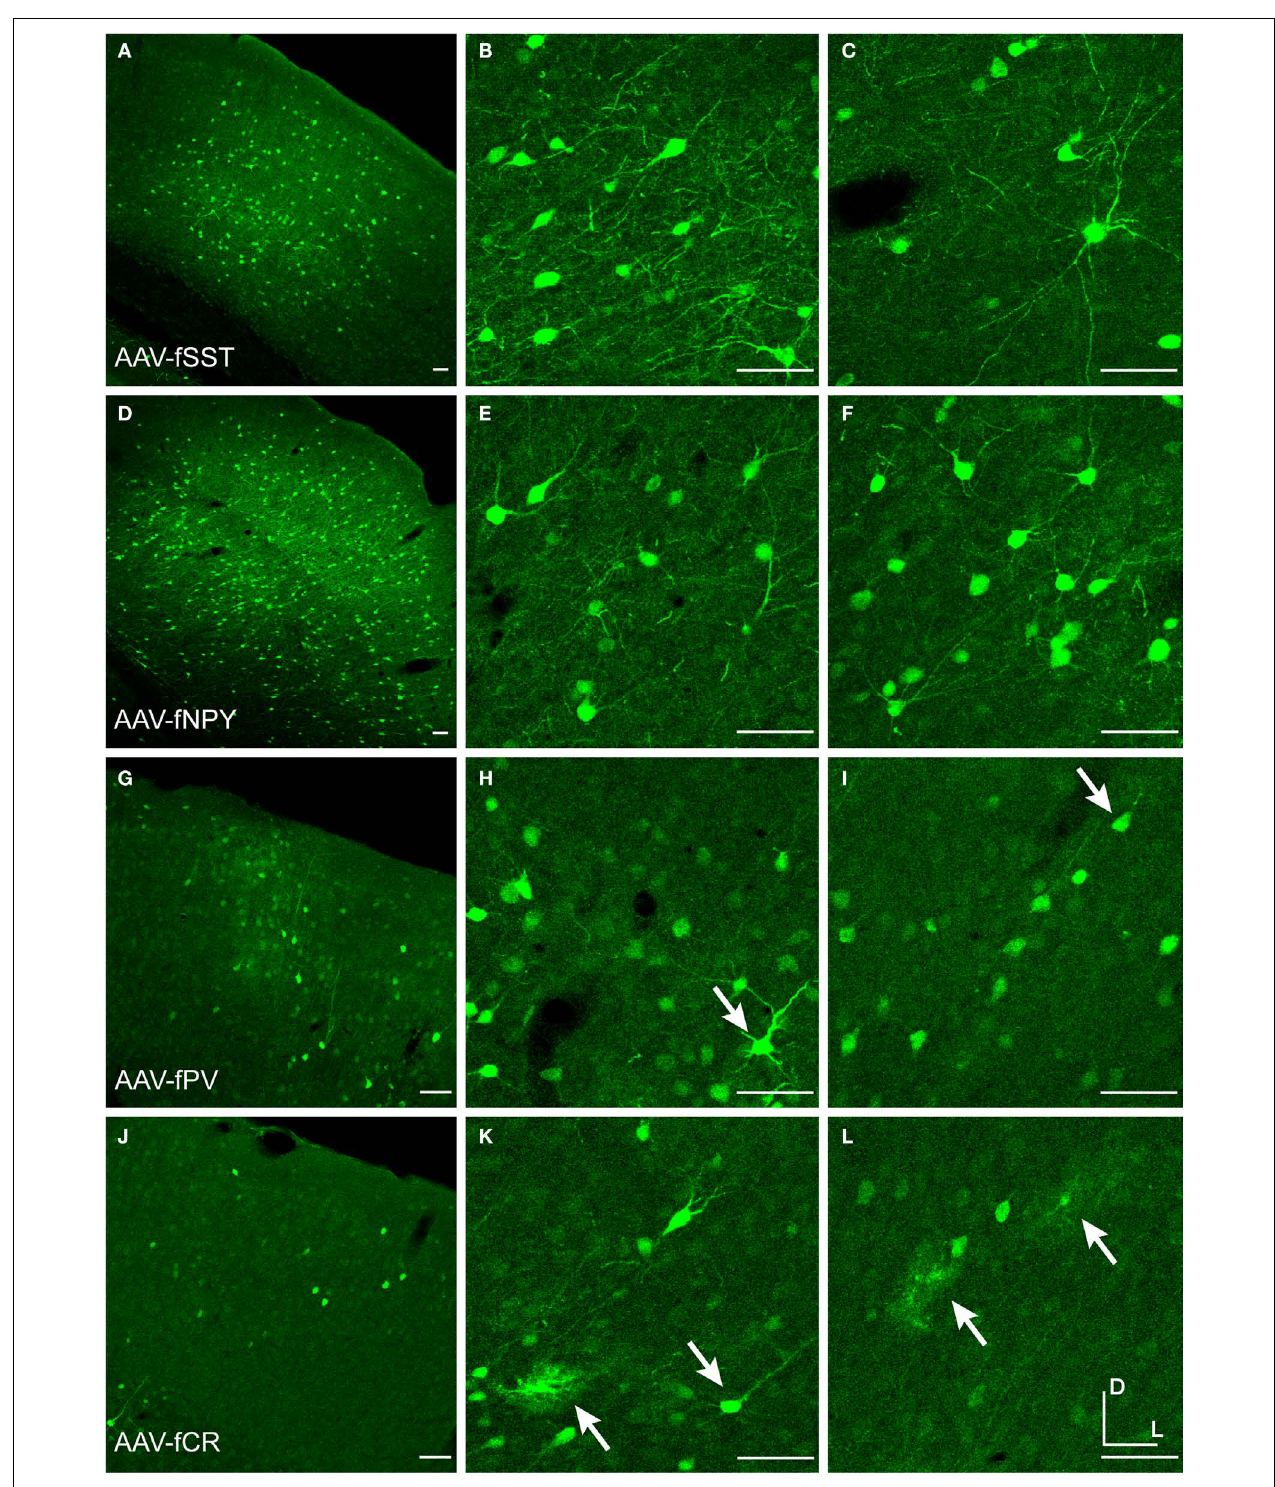
fugu promoters in AAV are shown in rows: somatostatin [AAV-fSST, (A – C) ], neuropeptide Y [AAV-fNPY, (D–F) ], parvalbumin [AAV-fPV, (G–I) ], and calretinin [AAV-fCR, (J–L) ]. Upward arrows mark glia and downward arrows mark excitatory pyramidal neurons. Dorsal (D) and lateral (L) directions for all images are as indicated in (L) . Scale bars are 50